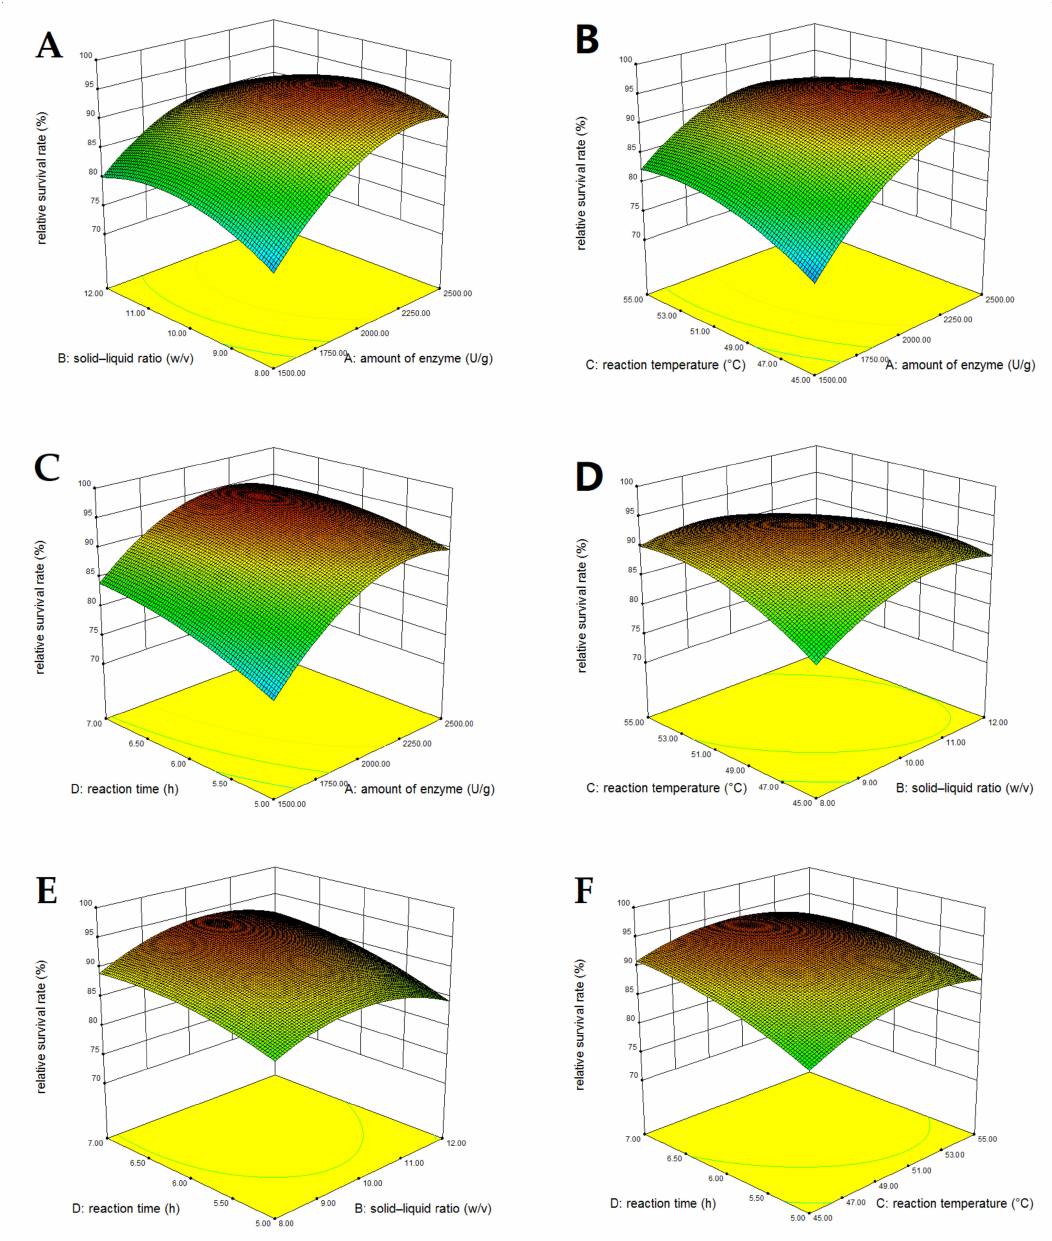
Figure 2. The interaction of independent variables on the relative survival rate of L. rhamnosus frozen at − 20 ◦ C for 24 h. The interaction between two independent variables were as follows: ( A ), the solid–liquid ratio and amount of enzyme; ( B ), the reaction temperature and amount of enzyme; ( C ), the reaction time and amount of enzyme; ( D ), the reaction temperature and solid–liquid ratio; ( E ), the reaction time and solid–liquid ratio; ( F ), the reaction temperature and reaction time. The measuring coefficient ( R 2 ) of the calibration equation was 0.9658, indicating an acceptable fitting relationship between the compounds with M w ranging from 189 Da to 12355 Da. Figure 3 shows the molecular weight distribution of APT, indicating that the M w fractions mainly were distributed between 1 kDa and 3 kDa (accounted for 63.37%). The M w of 3 k–10 kDa accounted for 25.64%. Wu et al. previously isolated antifreeze peptides from sericin with the M w of 1009.50 Da [29]. Meanwhile, Wang et al. obtained antifreeze peptides from pigskin with the M w distribution of 150–2000 Da [15]. The M w distribution of protein hydrolysates determines their biological and functional properties [30]. Antifreeze